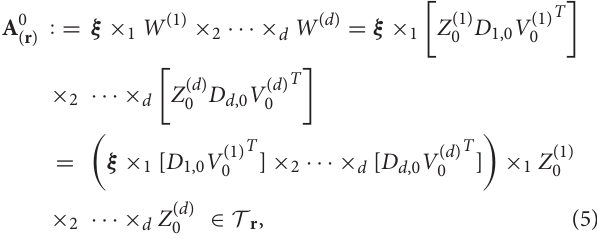
FIGURE 2 | A first step in canonical-to-Tucker